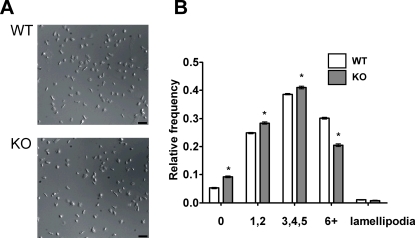
PKCθ positively regulates filopodia number when platelets spread on fibrinogen.Platelets were deposited on fibrinogen-coated coverslips in a live-cell chamber for 45 min and visualized by DIC microscopy. Five fields of view were selected at random, and one such field is shown in (A) for WT and PKCθ−/− platelets. In (B), filopodia number was counted for each visible platelet and the number of platelets with none, few (1–2), some (3–5) or many (6 or more) filopodia were expressed as a proportion of the total number of platelets in view. Shown are combined data from three independent experiments. Bar indicates 10 µm.